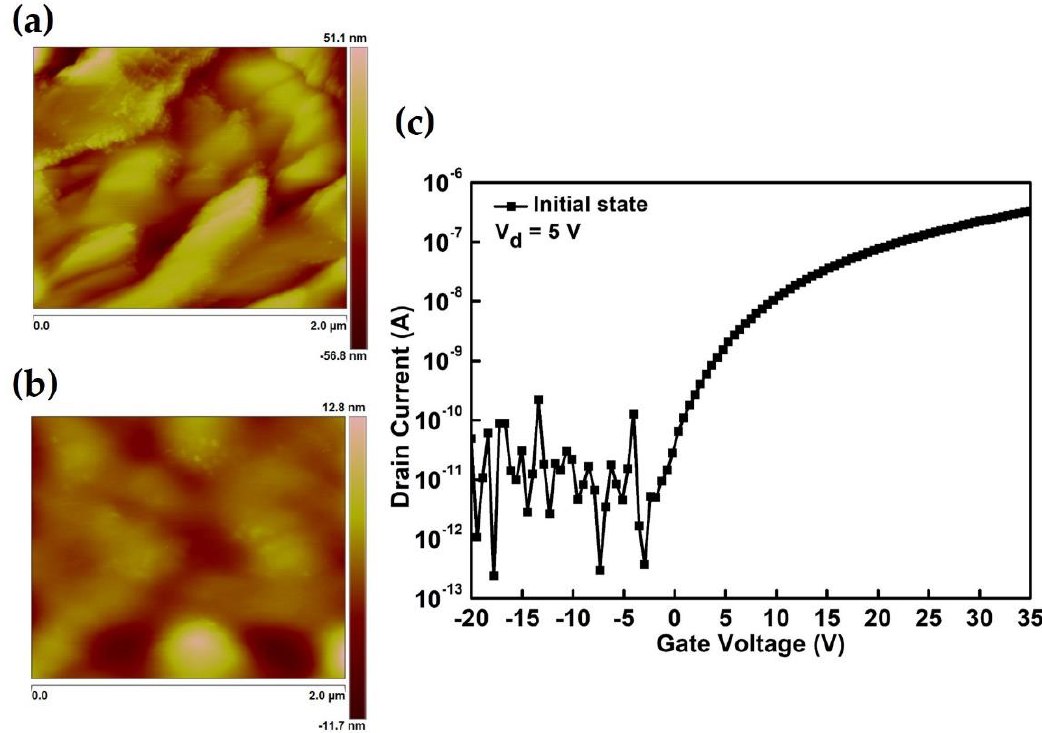
Figure 3. Atomic force microscopy images of the semiconducting channel ZnO thin film spray-deposited at the distances of ( a ) 10 cm and ( b ) 20 cm between the spray nozzle and substrate. ( c ) Transfer characteristics of drain-source current versus gate voltage (I DS -V GS ) of two layers of several semiconducting channel ZnO thin films deposited at a distance of 20 cm between the nozzle and substrate.